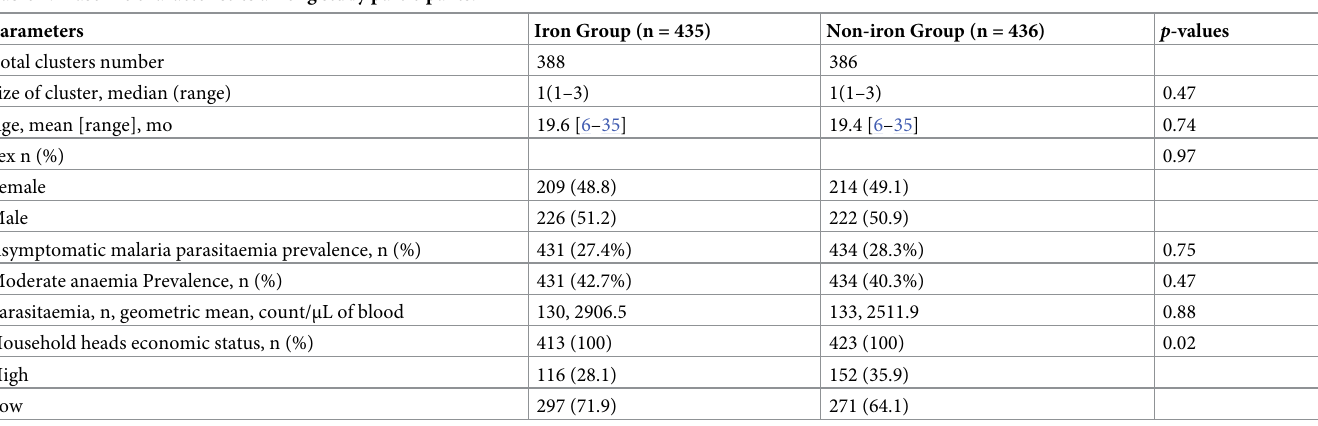
Table 1. Baseline characteristics among study participants.